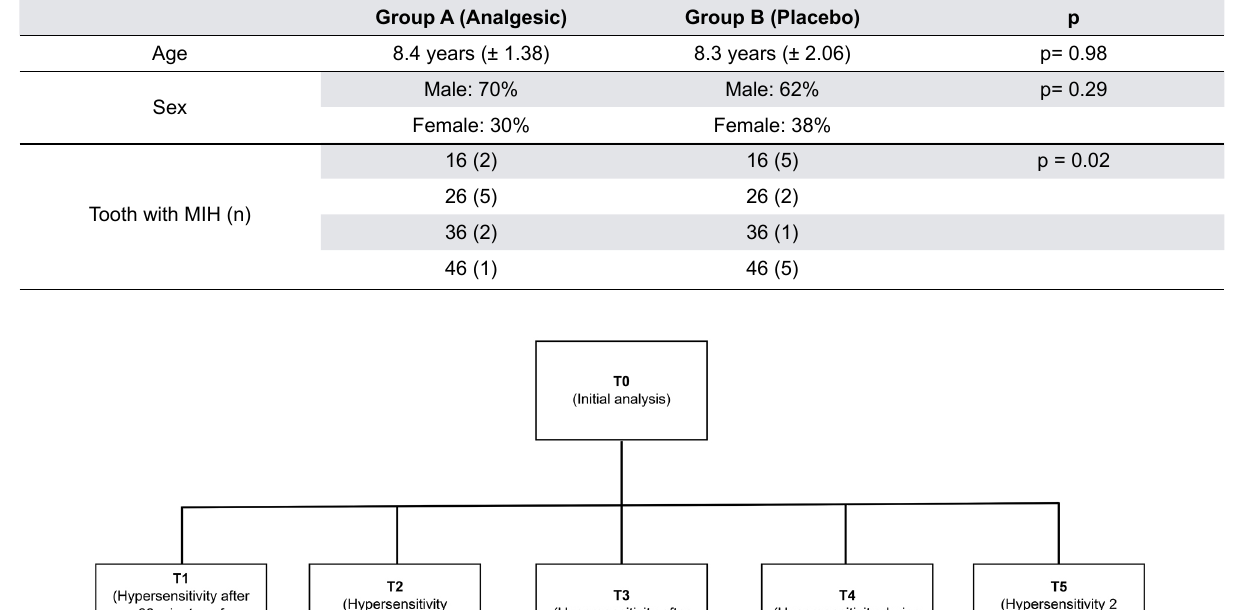
Preemptive analgesia with ibuprofen increases anesthetic efficacy in children with severe molar: a triple-blind randomized clinical Table 1- Demographic data and distribution of teeth with MIH in the groups